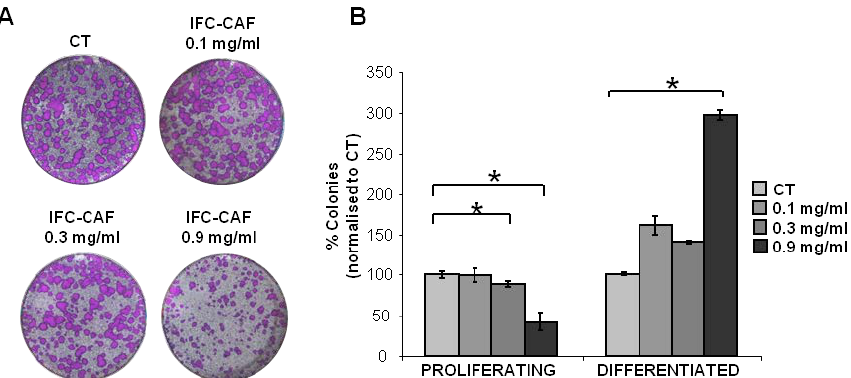
Figure 1. IFC-CAF ® delays colony growth of human primary epidermal stem cells. ( A ) Representative clonogenicity assays across the indicated conditions, stained with Rhodanile blue after 12 days of treatment. Ct: control cultures with the same dilution of the vehicle. ( B ) Results from two independent experiments are summarised as a percent of colonies belonging to each phenotypic category, across the four indicated conditions and normalised to the Ct cultures. Statistical significance was assessed by the Student´s t test (*: p < 0.05 vs Control).